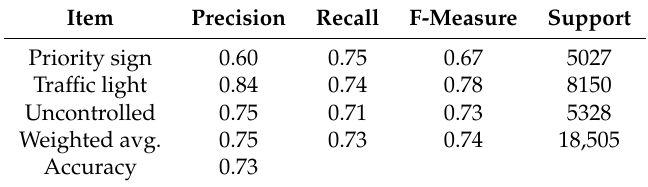
Table 4. The results of detecting traffic regulators for the signal-wise classification by the CVAE model.